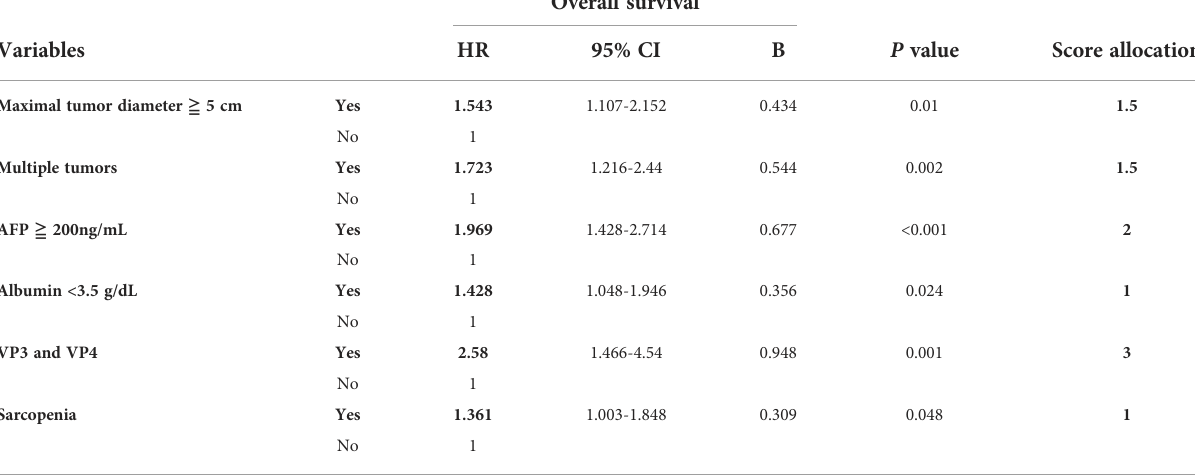
TABLE 4 Cox regression multivariate analysis of prognostic factors for overall survival in HCC patients receiving TACE.